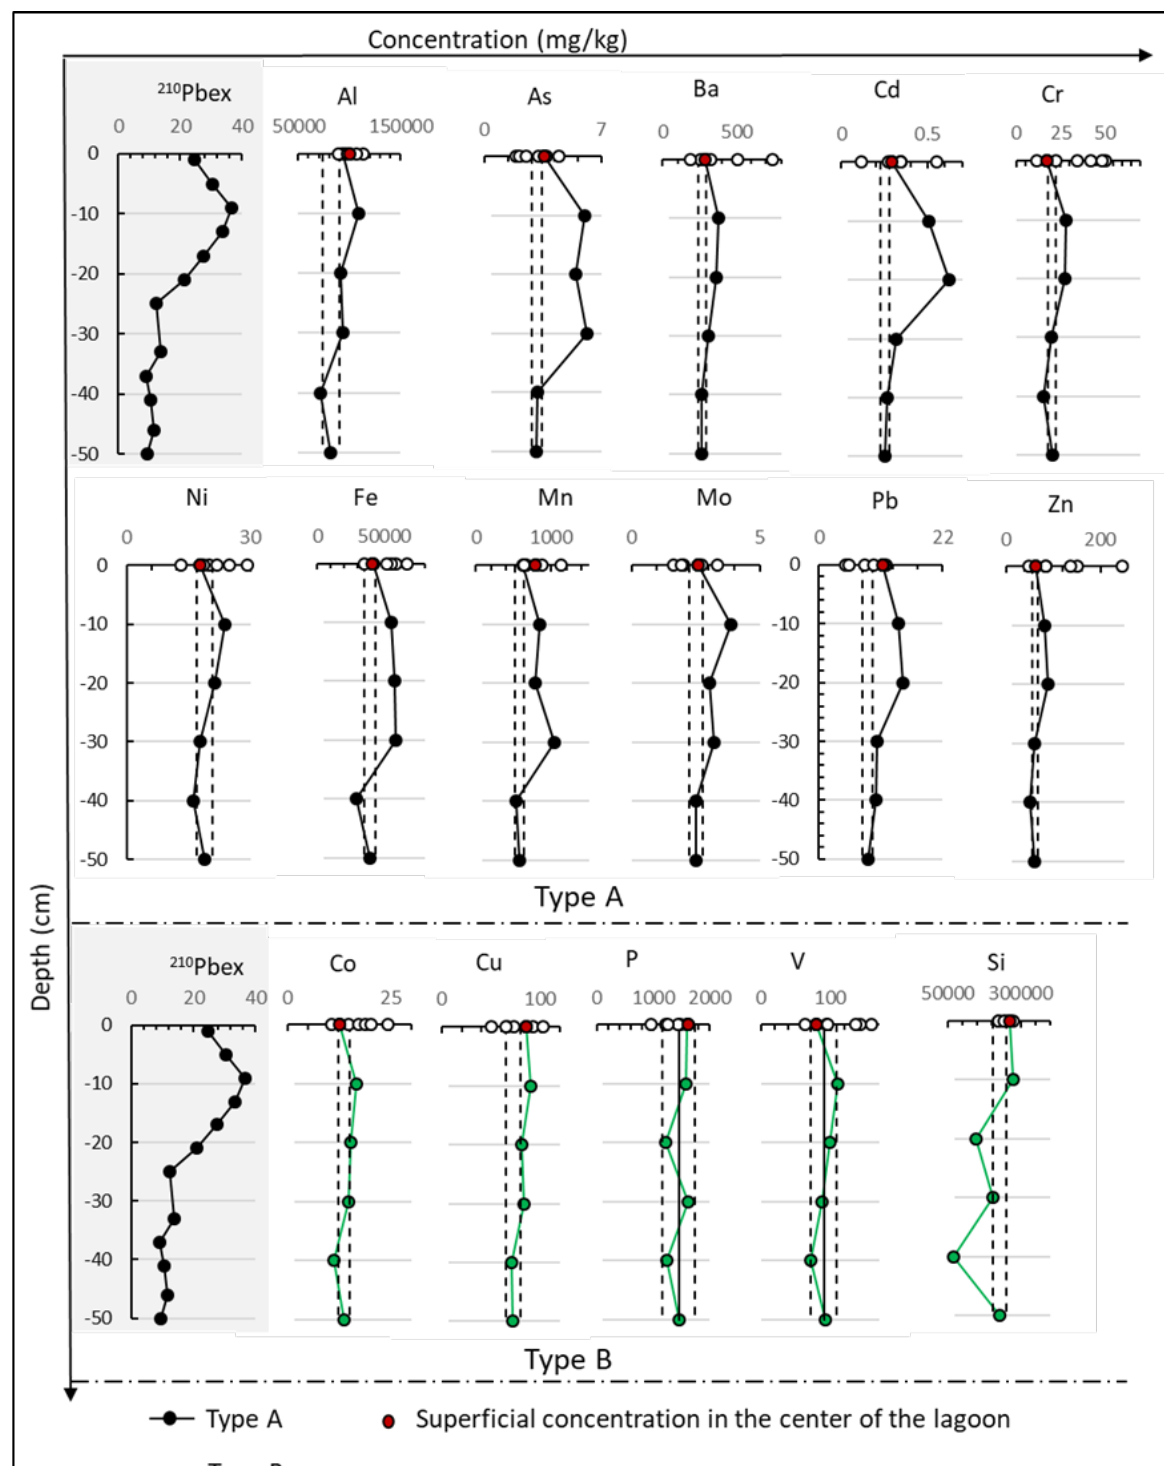
Figure 4. Profile of major, minor elements and 210 Pb excess from a sediment core in Limoncocha lagoon and comparison to the superficial sediment concentrations (ο) .